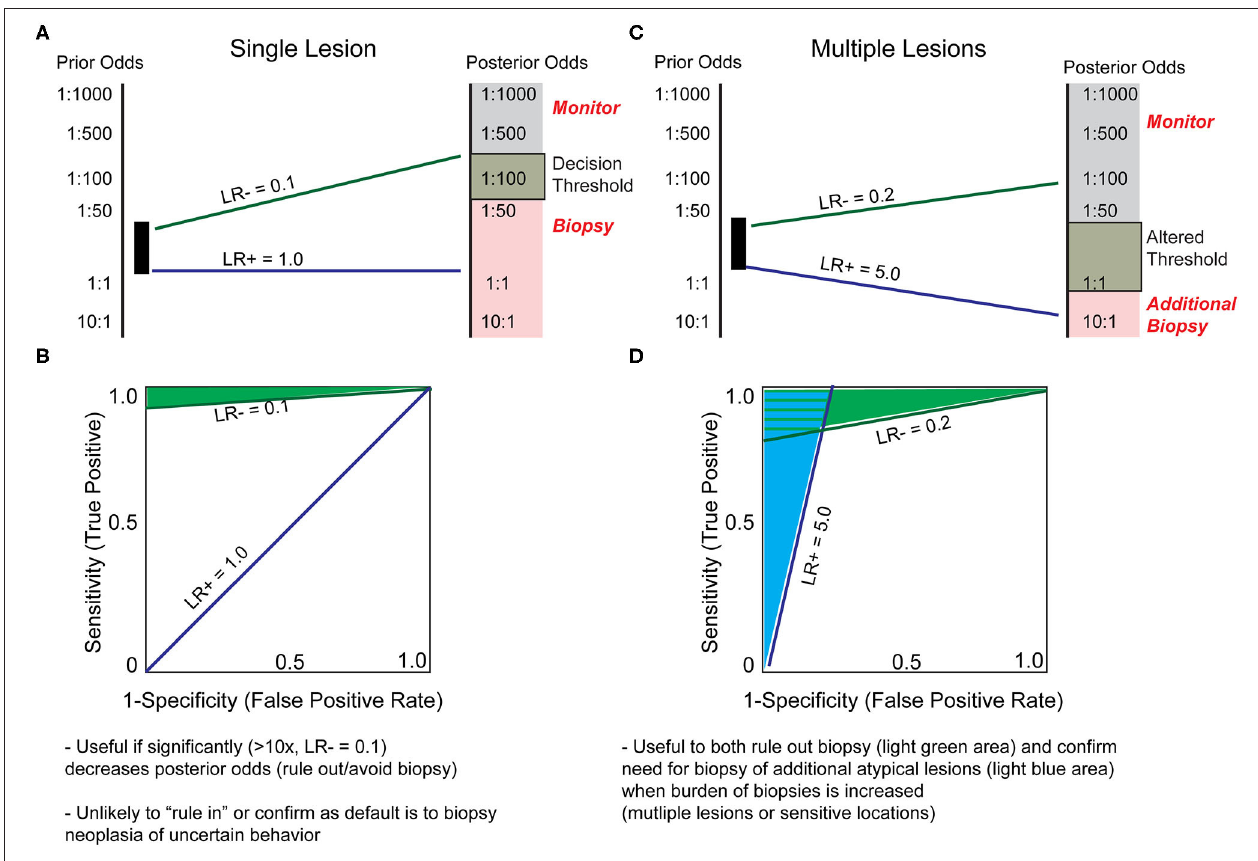
FIGURE 3 | Hypothetical biomarker test characteristics to assist in deciding to biopsy. (A) Solitary lesions with perceived prior odds of malignancy estimated at 1:2 to 1:30 are typically biopsied due to the minimal pain and expense of biopsy. Therefore, a test’s LR + characteristic is not generally valuable when evaluating a single lesion. In contrast, a LR– of 0.1 indicates a 10-fold decrease in likelihood of malignancy, and may inform the decision to not biopsy. (B) LR + and LR- slopes from (A) plotted on a receiver operating characteristic (ROC) curve, indicate the hypothetical test characteristics required of a biomarker to provide clinically meaningful decision to biopsy a suspicious lesion, with the area shaded in green representing estimated test characteristics useful in ruling out biopsy. (C) The estimations and assumptions change when a single patient presents with numerous borderline lesions. Due to limited patient tolerance for multiple biopsies, there may be an increased threshold to biopsy each additional lesion. A test designed to address these parameters would have different test characteristics. For instance, a LR– ≤ 0.2 might convince a provider to defer biopsy on a lesion, and a LR + ≥ 5 could prompt a biopsy for a lesion that would have otherwise been monitored. (D) In the setting of multiple lesions, the question of which lesions to biopsy may be more readily influenced with biomarker testing, as indicated by the light blue shaded area (shift from indecision to biopsy) or light green shaded area (shift from indecision to monitor). These assumptions representing a higher burden of biopsy and altered threshold may also apply to biopsies of sensitive areas such as face, genitals, or nail